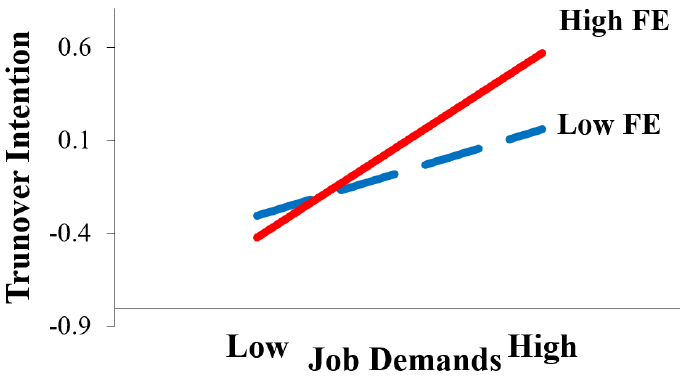
Figure 1. Interaction Plot. Note: FE = fun environment.